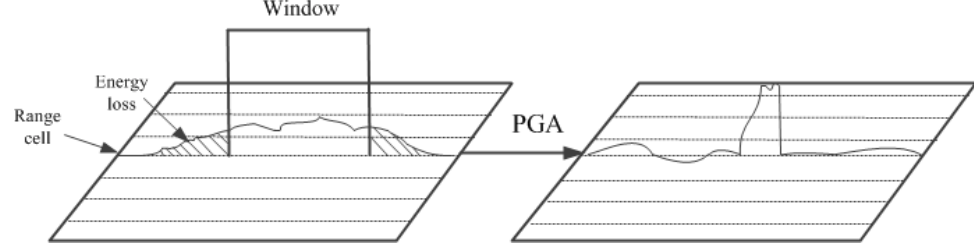
Figure 8. The main lobe widening and energy loss seriously affected the performance of PGA.